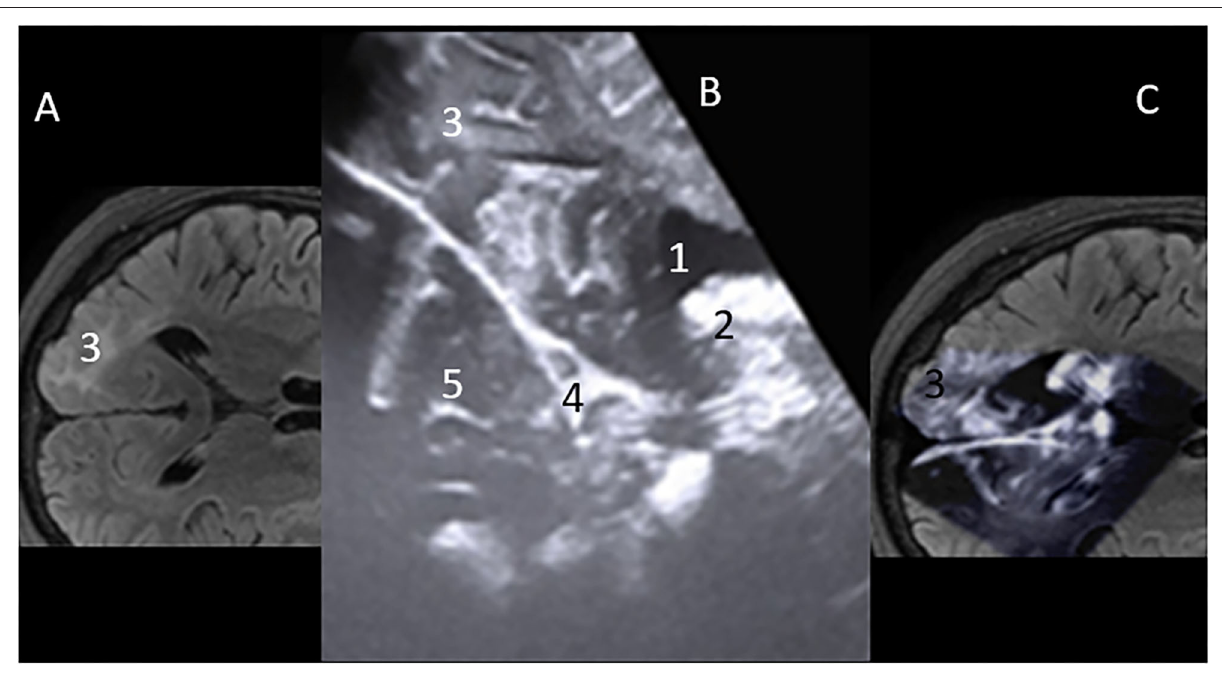
Frontiers in Surgery |